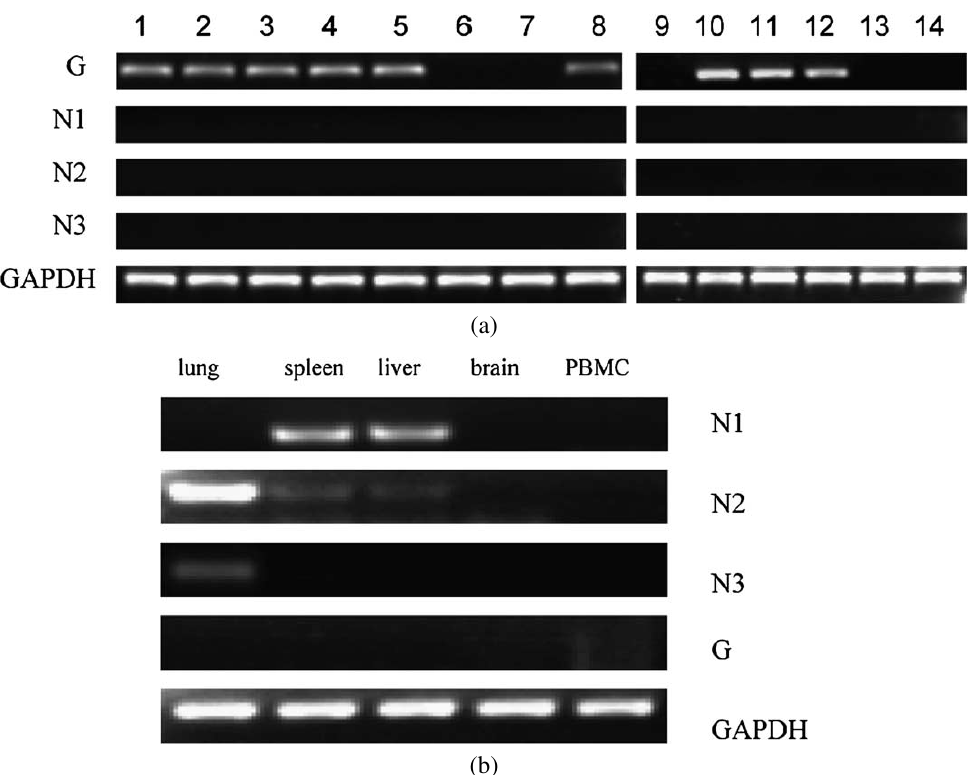
Fig. 1C. RT-PCR analysis the expression of human IL-13Ra2 transcripts (N1, N2, N3, G) in tumor cell lines and some normal tissues. Primers for human GAPDH were used as positive control, for every reaction, and water without template was used as a negative control. (a) The expression of IL-13Ra2 transcripts in tumor cell lines (1. U87, 2. U118, 3. U138, 4. U373, 5. CRL1620, 6. K562, 7. Jurkat, 8. CRL2365, 9. HL60, 10. GBM3, 11. GBM4, 12. SF295, 13. GBM1, 14. colo205). (b) The expression of human IL-13Ra2 transcripts in some normal human tissues (lung, liver, spleen, brain, PBMC). RT-PCR products were electrophoresed and stained with Gelstar (Biowhittaker Molecular Applications, Rockland). The gel electrophoresis from one of three representative sets of PCR reactions is